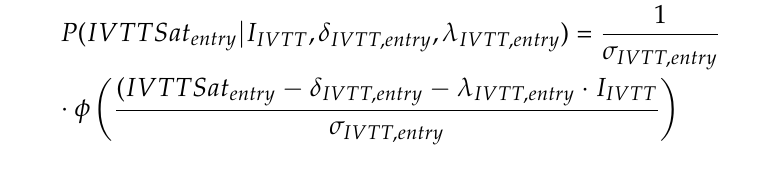
Table 1. List of coefficients of the structural